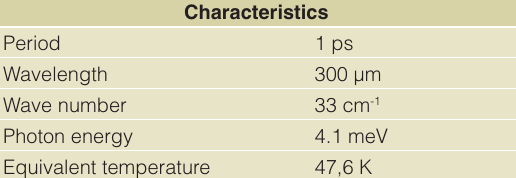
Table 1. Characteristics of radiation at 1